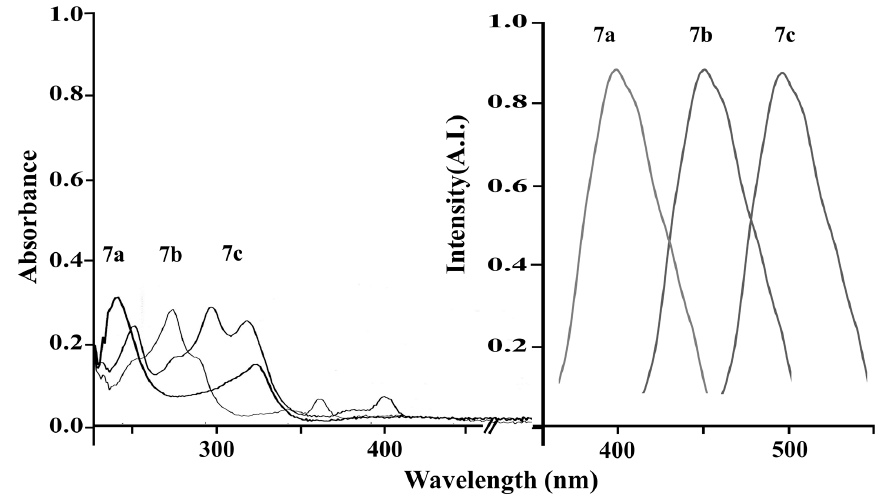
Figure 2. UV absorption and photoluminescence (PL) spectra of 7a , 7b , and 7c in EtOH (1 × 10 − 6 M) at 298 K.